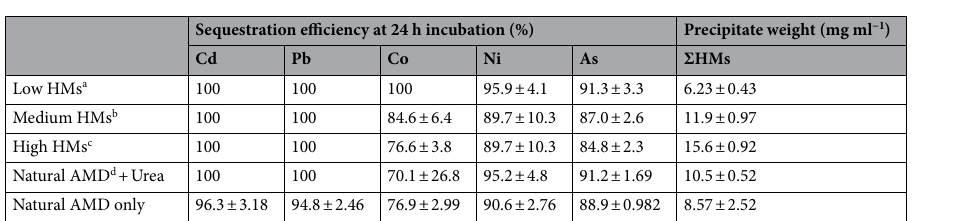
Figure 5. Growth kinetics of bacterial consortium via viable counts extrapolated into optical density at 600 nm wavelength ( a ) and growth-dependent urease activity of bacterial consortium ( b ) in TGYM broth without heavy metals (HMs) cocktail, and with low, medium, and high concentrations of HMs cocktails. Low HMs concentrations cocktail comprised (per liter) Cd, 27.9 mg; Pb, 118.7 mg; Co, 16.2 mg; Ni, 16.2 mg; and As, 61.5 mg. While medium HMs concentration contained (per liter) Cd, 55.7 mg; Pb, 237.3 mg; Co, 32.4 mg; Ni, 32.3 mg; and As, 123.1 mg. High HMs concentration contained (per liter) Cd, 139.3 mg; Pb, 593.3 mg; Co, 81.1 mg; Ni, 80.7 mg; and As, 307.6 mg. The mean pH at the beginning of experiment was 3.5 and rose to 8.2–8.4 at 48 h post-inoculation. Growth kinetics at exponential growth phase are in the inserts of panel ( a ), where ‘Td’ represents doubling time and ‘K’ is the growth rate at exponential growth phase. Error bars represent standard error mean (SEM) of triplicate experiments. The culture conditions were as explained in the “Methods” Section (Growth kinetics and urease activity of bacteria consortium; Determination of bacterial growth- dependent HMs/metalloid sequestration in simulated and natural AMD).